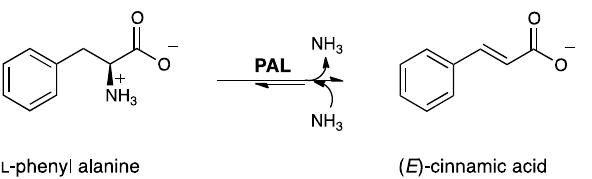
Figure 1. Ammonia elimination of L -phenylalanine and reverse ammonia addition to ( E )-cinnamic acid catalyzed by PAL.